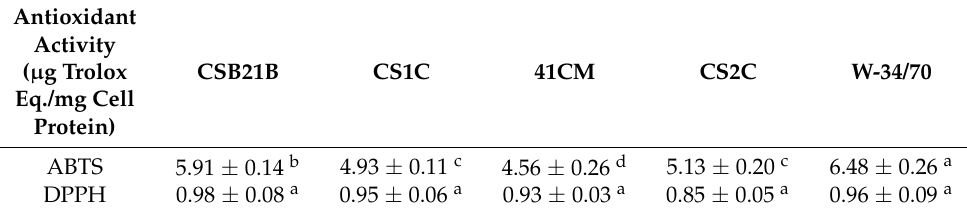
Table 2. Antioxidant activity of S. cerevisiae CSB21B, CS1C, CS2C, 41CM and S. pastorianus W-34/70 strains by DPPH and ABTS methods. Data are expressed as means ± standard deviation obtained in three independent experiments ( n = 3); lower case letters indicate significant differences within row ( p <